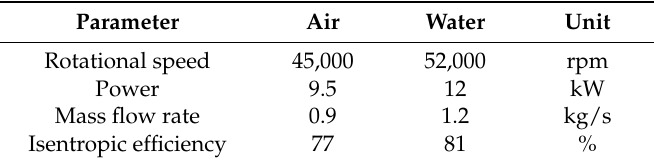
Table 4. Working parameters of the turbine with air and